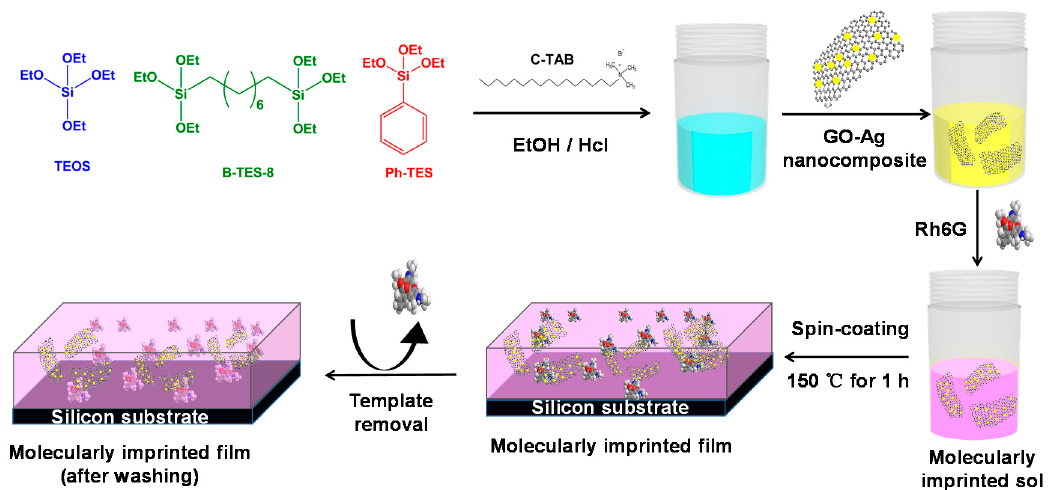
Figure 1. Schematic illustration of the preparation of a molecularly imprinted film containing graphene oxide Silver nanoparticles (MIF@GO-AgNPs). Tetraethylorthosilicate (TEOS), phenyltriethoxysilane (PhTES) and bis(triethoxysilyl)octane (B-TES-8) precursors build up the silica hybrid matrix embedding graphene oxide Silver nanoparticles (GO-AgNPs). Rhodamine 6G (Rh6G) acts as a molecular template; the surfactant cetyltrimethylammonium bromide (CTAB) provides the porosity by self-assembly. The film is deposited via spin-coating and removal of Rh6G and CTAB has been obtained by using ethanol to wash the samples.